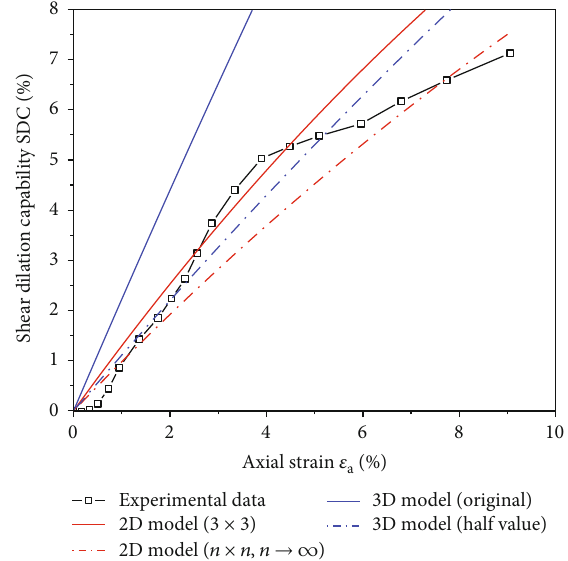
Figure 13: Curve fi tting of experimental axial strain-SDC curves by proposed theoretical